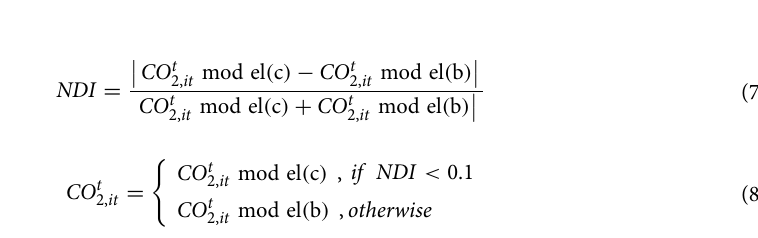
Table 1. Results for the panel regressions between the provincial carbon emissions and the SDN values. (1) ***Denote significance at the 1% level. (2) The values in parentheses are standard errors. (3) Models (a), (b), (c) and (d) represent the results estimated based on fixed-effect models, estimated by variant slope models, from the use of variant slopes and individual fixed effects, and from the use of variant slopes and individual and time fixed effects, respectively. (4) AIC represents the Akaike information